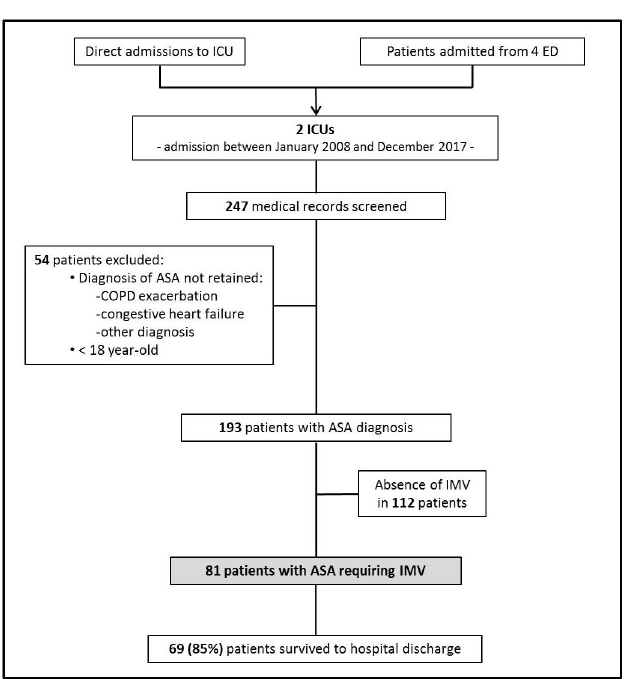
Fig 1. Flowchart of patient selection. ICU: intensive care unit; ED: emergency department; ASA: acute severe asthma; COPD: chronic obstructive pulmonary disease; IMV: invasive mechanical ventilation.